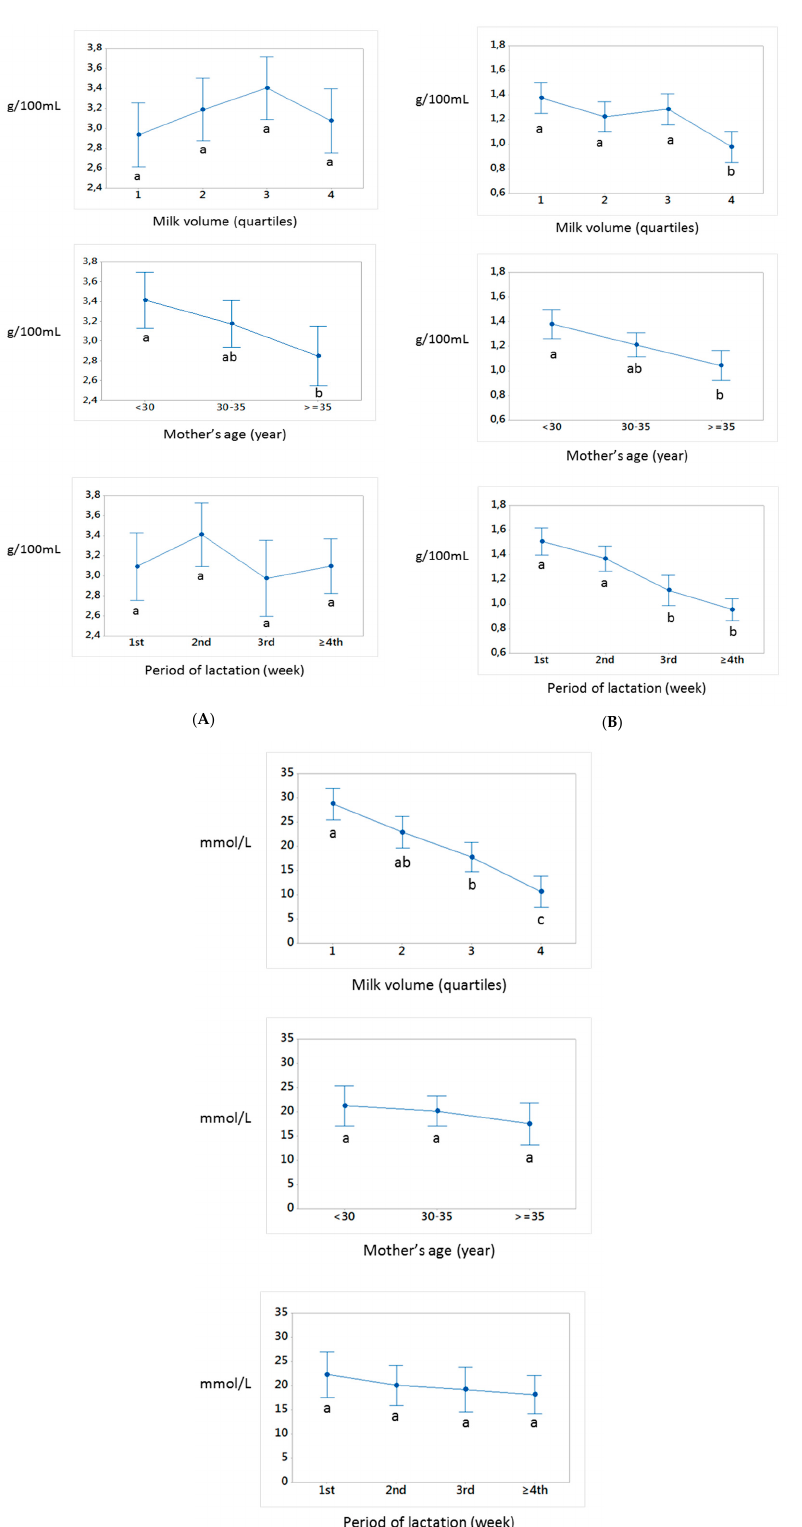
Figure 1. Associations between maternal age, average volume, and lactation period with protein ( A ), fat ( B ), and sodium ( C ) concentrations. Differences in mean ± SD for each nutrient were tested using fat ( B ), and sodium ( C ) concentrations. Di ff erences in mean ± SD for each nutrient were tested ANOVA with post hoc Tukey’s test. Different letters ( a – c ) confer statistically different mean values.